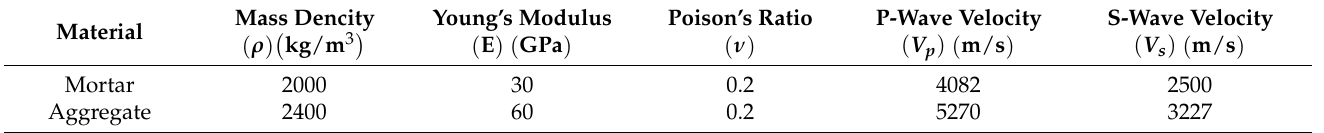
Figure 2. Numerical configuration of a damaged concrete model with random aggregates. The model size was 400 mm × 400 mm. Cracks at different angles to the horizontal were located in a circular damage zone centered at (200 mm, 200 mm). The size of the crack was initially set to be 20 mm × 0.05 mm. Table 1. Properties of the materials used in the numerical simulation